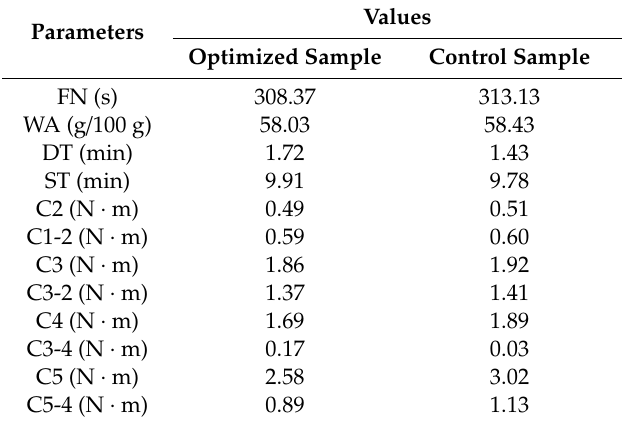
Table 3. Optimized quinoa-wheat flour dough compared to the wheat flour control sample. Values Parameters Optimized Sample Control Sample FN (s) 308.37 313.13 WA (g / 100 g) 58.03 58.43 DT (min)